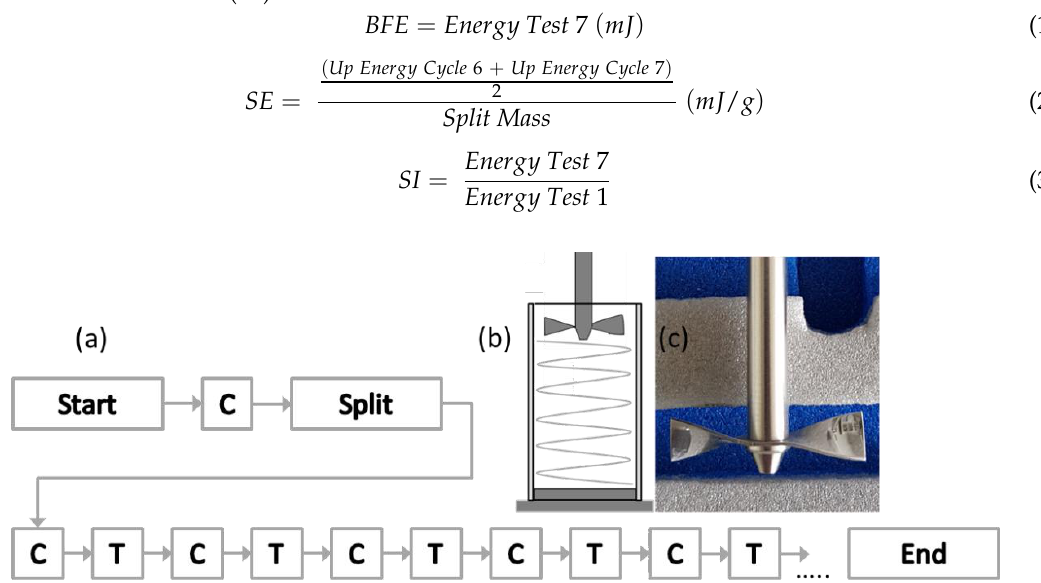
Figure 1. Fluidity test methods for ( a ) the stability test sequence (C = conditioning cycle, T = test cycle), ( b ) schematic representation of the blade motion, both adapted from [43] and ( c ) photograph of the 23.5 mm testing blade.